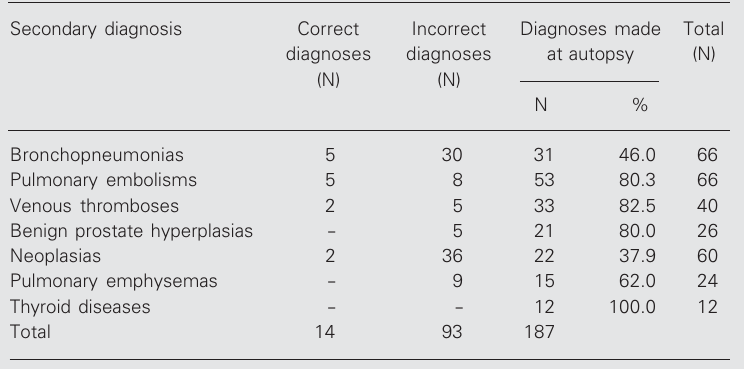
Table 4. Secondary diagnoses: more frequent discrepancies between clinical diagnoses and autopsy findings, verified during two periods (1975-1982 and 1992-1996), at Facul- dade de Medicina de Botucatu, São Paulo,